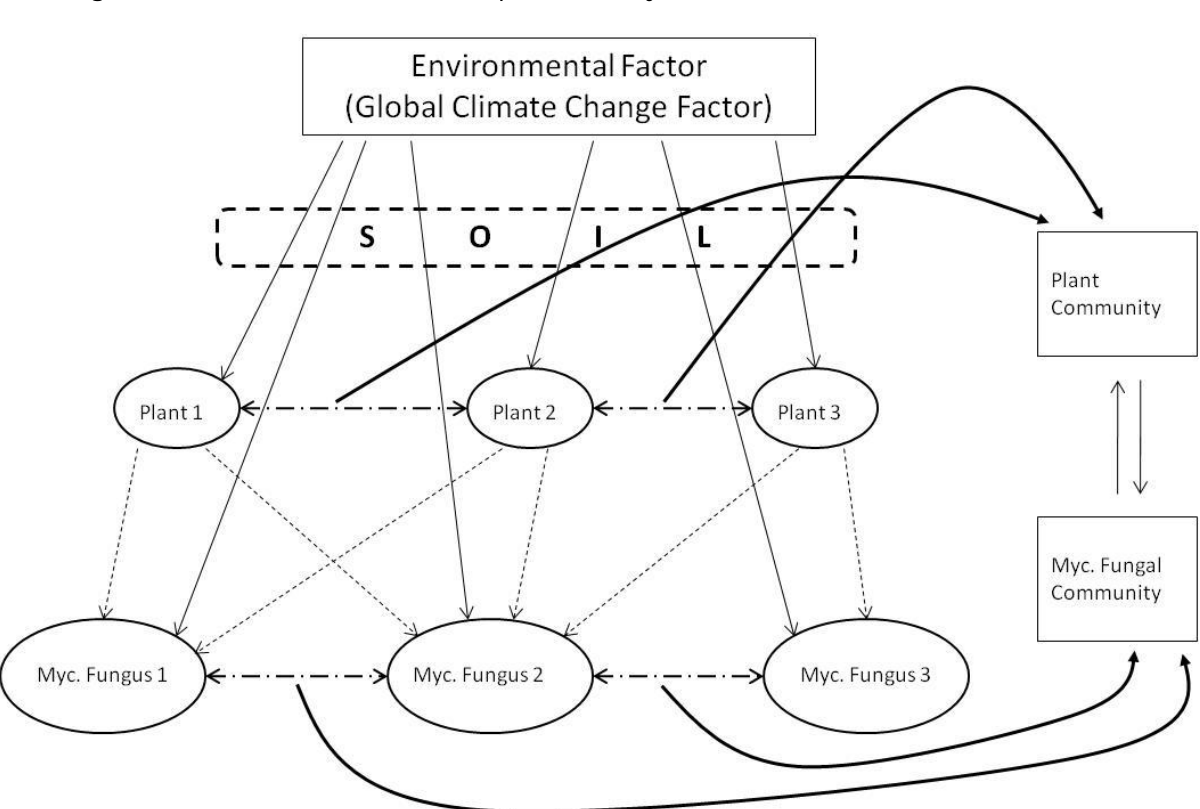
Figure 2. Direct and indirect impacts of an environmental factor, here envisioned as a global climate change (GCC) factor, on a simplified mycorrhizal fungal community. An environmental factor (GCC factor) can have direct affects on both plants and associated mycorrhizal fungi (solid arrow →). The factor can also affect mycorrhizal fungi indirectly via impacts on the plant-host (dashed arrows ). Interspecific interactions (dot-dashed double arrows ) at levels of plants and mycorrhizal fungi attenuated by climate, topography, other organisms, geological substrates, and maturity of the system will determine plant and mycorrhizal community structure (curved solid arrow ). Finally, the plant and mycorrhizal fungal communities both influence one another (double two-way arrows